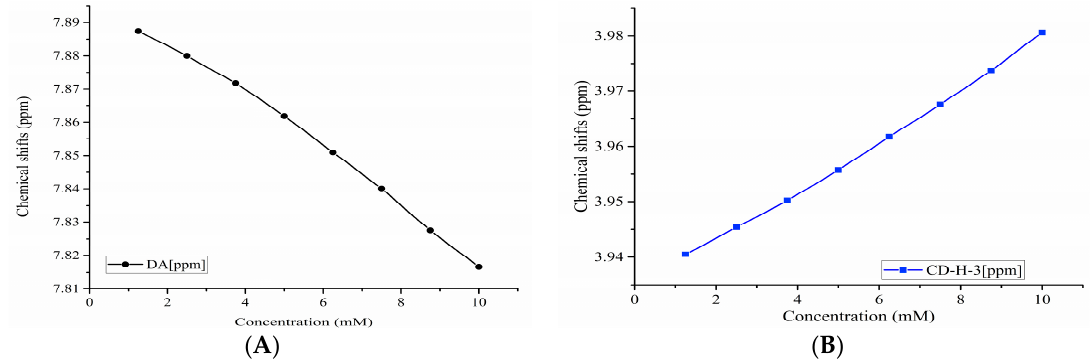
Figure 6. Chemical shifts variation as a function of β CD concentration of: ( A ) 7.82 ppm protons of DA and ( B ) H-3 of β CD protons.